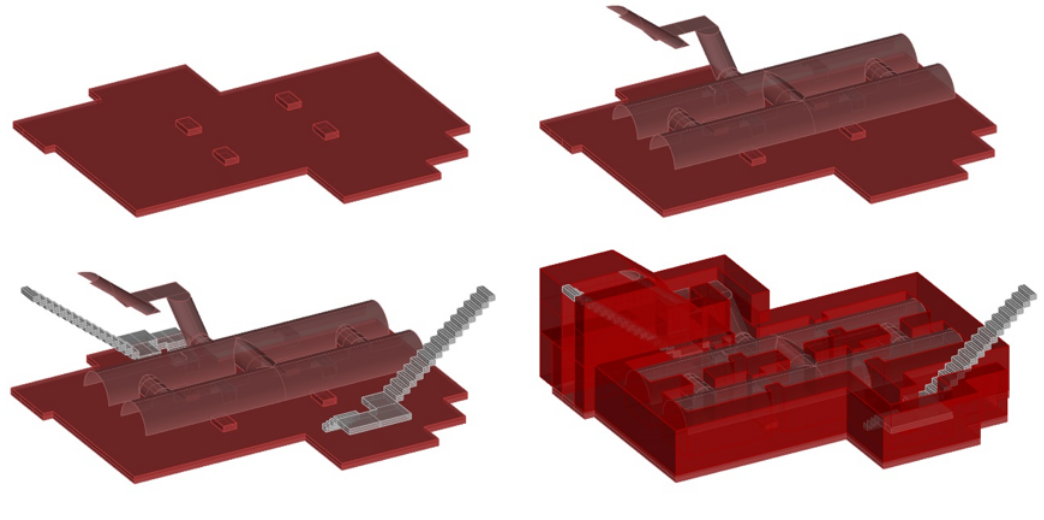
Figure 5. Images of the reconstruction in 3D of the refuge of Plaza Balmis, showing the two longitudinal naves that form three quarters each connected in both